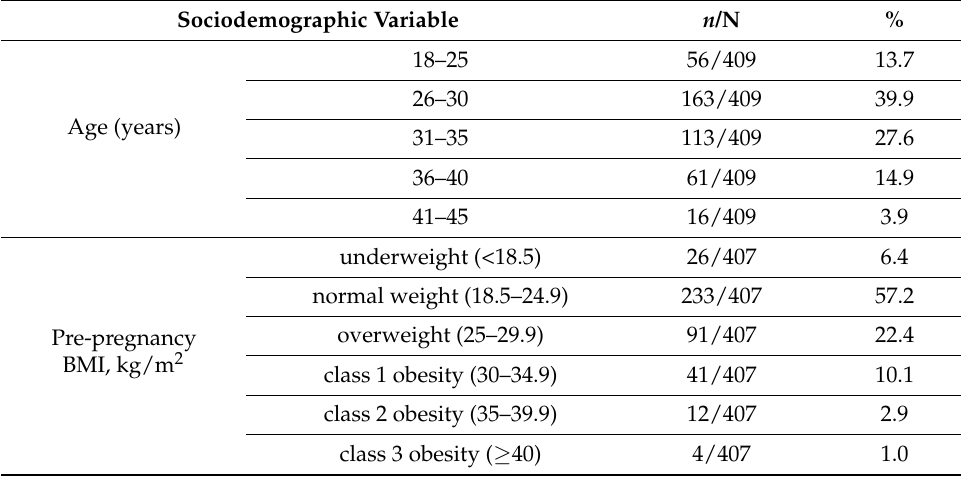
Table 1. Participants’